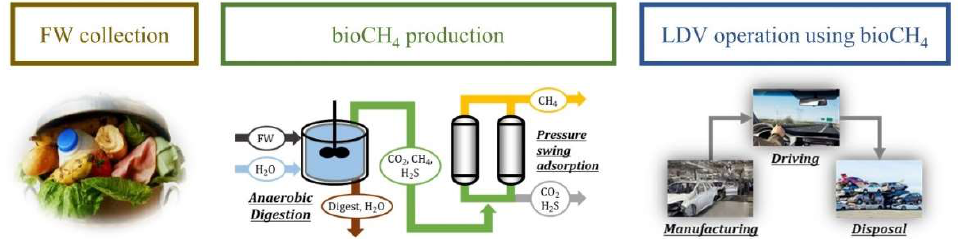
Figure 2. System boundaries for the lifecycle assessment of food waste (FW)-based green methane production and light-duty natural gas vehicle (LDNGV) operation in China.